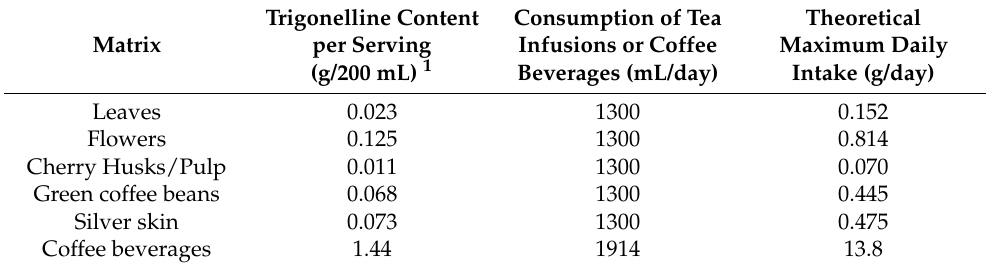
Table 3. Theoretical maximum daily intake of trigonelline via coffee and coffee by-products.